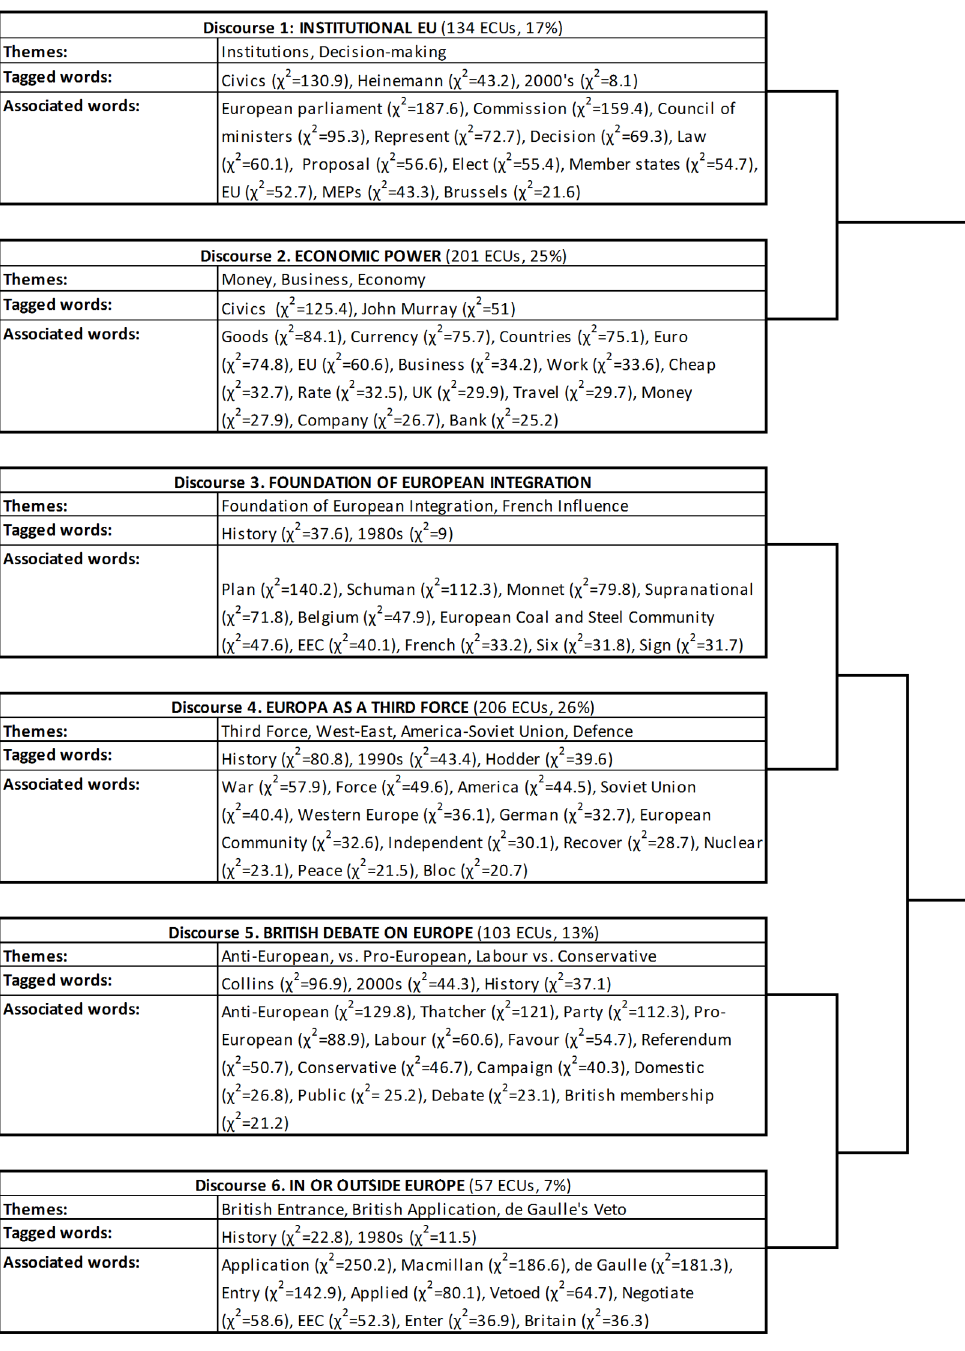
Figure 2. The results of ALCESTE analysis in English